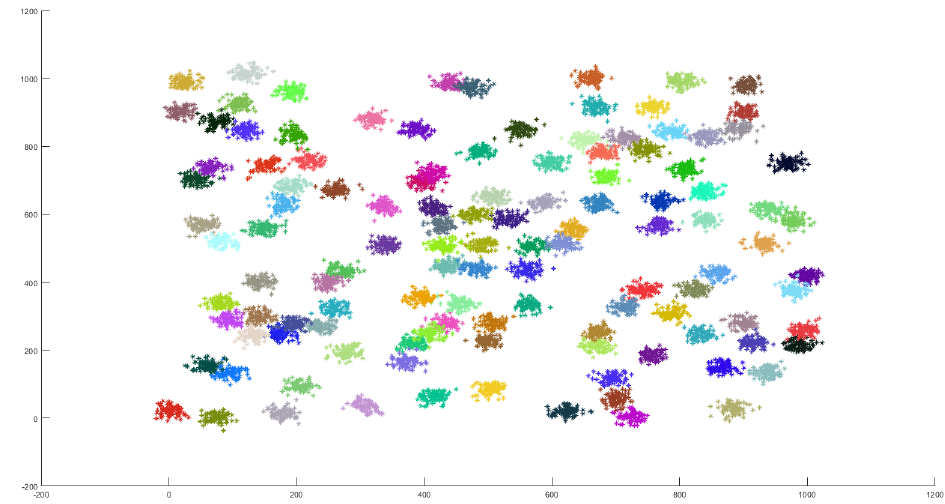
Figure 2. The synthetic dataset distribution diagram.